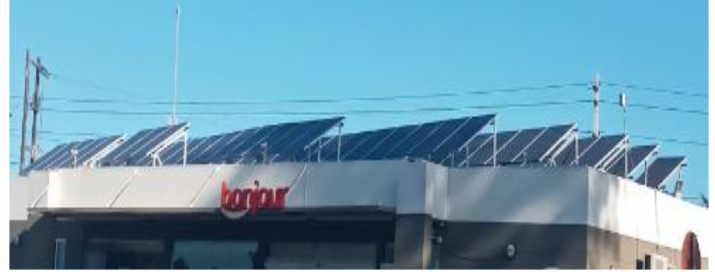
Figure 5. Solar PV system in Matola N4 (B).